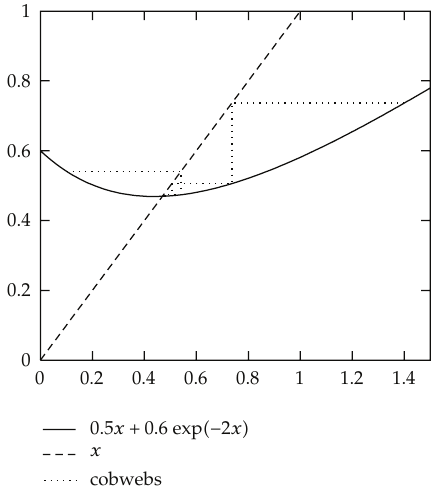
Figure 1: The graph of the function (cid:4) 3.1 (cid:5) demonstrates that, unlike most unimodal functions in population dynamics models, f (cid:4) x (cid:5) decreases for small x and increases for large x , thus having a minimum, not a maximum. Here α (cid:8) 0 . 5, p (cid:8) 0 . 6, q (cid:8) 2, x ∗ ≈ 0 . 438, x ≈ 0 . 47 > x ∗ . The graph incorporates some iterations which converge (cid:4) monotonically, beginning with the second iteration (cid:5) to the positive equilibrium.